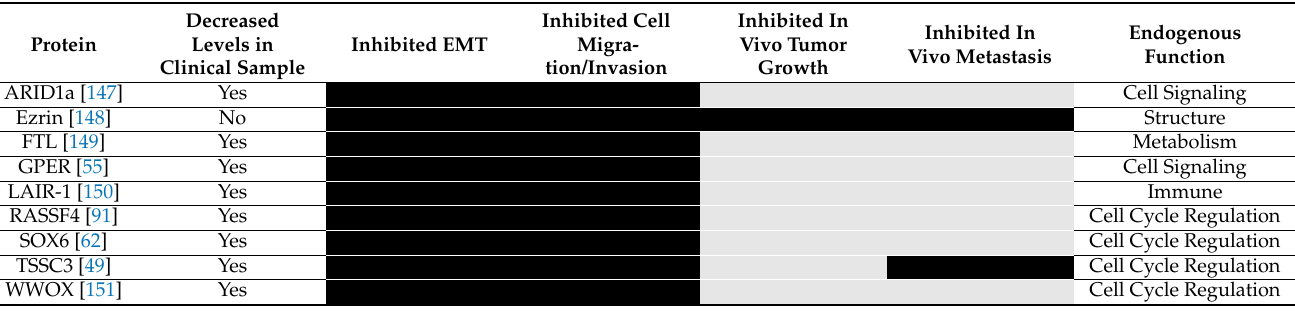
Table 2. Effects of poorly expressed proteins in OS.